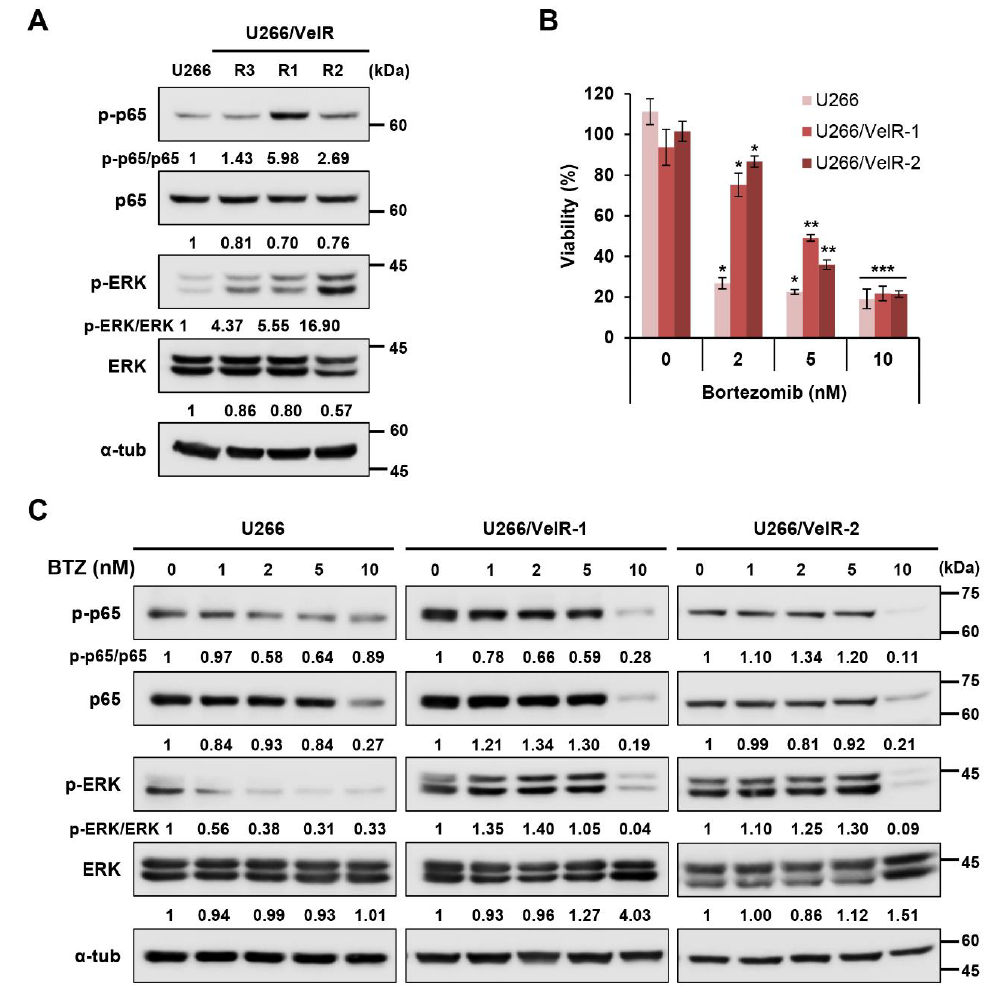
Figure 1. Establishment of bortezomib (BTZ)-resistant U266/VelR MM cells. ( A ) Immunoblotting analysis of both BTZ- sensitive U266 and BTZ-resistant U266 (U266/VelR-1, U266/VelR-2, and U266/VelR-3) MM cells. ( B ) Both BTZ-sensitive and BTZ-resistant U266 cells were treated with indicated concentrations of BTZ (2, 5, 10 nM) for 72 h, and cell counting kit-8 (CCK-8) assays were performed to analyze cell viability. Data represent mean ± SD ( n = 3). Student’s t -test, * p < 0.05, ** p < 0.01, and *** p < 0.001 vs. the DMSO control. ( C ) Immunoblotting analysis of both BTZ-sensitive U266 and BTZ- resistant U266 cells treated with 0.01% DMSO or indicated concentrations of BTZ (1, 2, 5, and 10 nM) for 24 h. Relative protein expression levels were semi-quantified by densitometric analysis of the blots. α-tubulin was used as an equal loading control. The abundance of the indicated proteins was semi-quantified relative to α-tub, and control levels were set at 1.